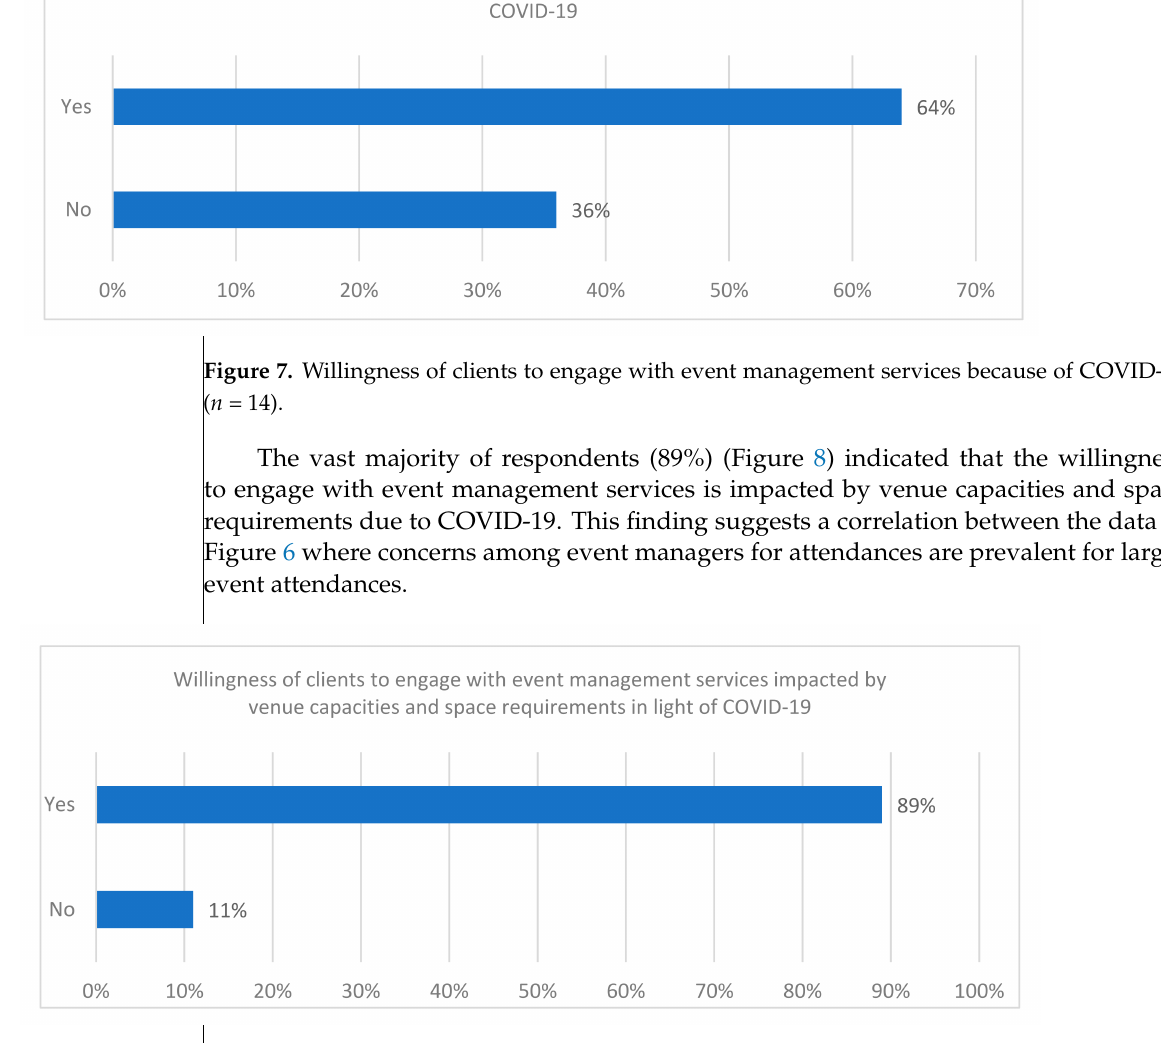
Figure 8. Willingness of clients to engage with event management services impacted by venue capacities and space requirements in light of COVID-19 (N =